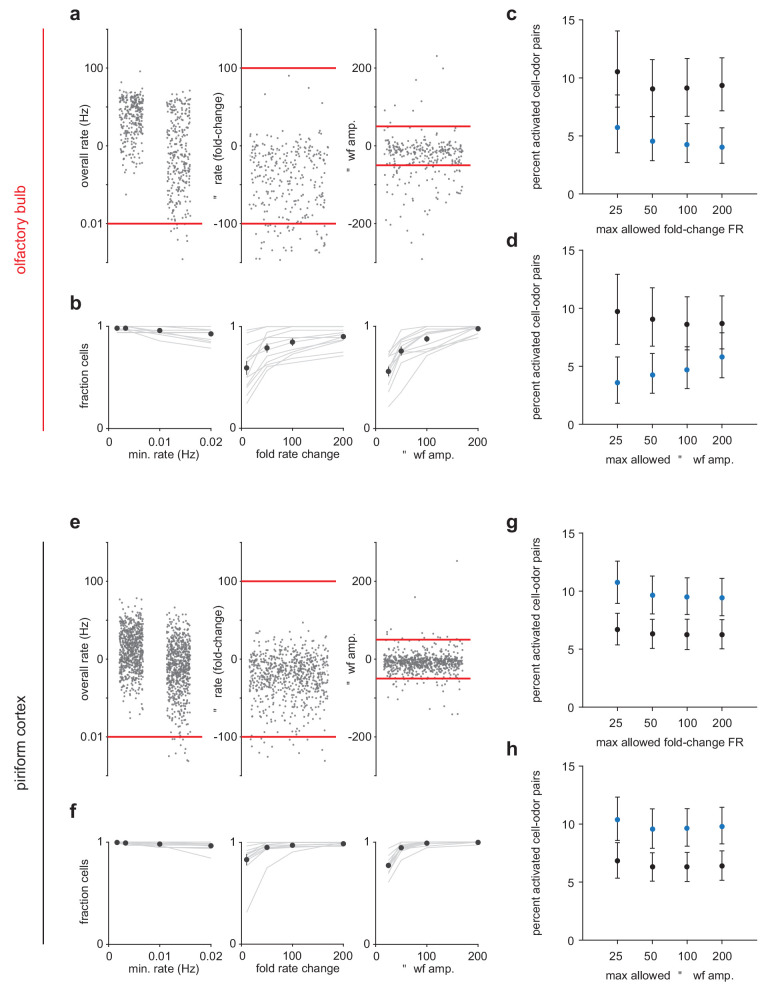
Criteria for maintaining sorted unit identity across states.(a) Left, Overall firing rates for all sorted OB units. Units falling below one spike in 0.01 Hz in either state were excluded. Middle, Fold-change in overall firing rate across states. Units with a greater than 100-fold change were excluded. Right, Change in waveform amplitude across states. Spike amplitudes for each unit were measured on the channel with the largest peak-to-peak waveforms. Units with greater than 50 μV changes in peak-to-peak amplitude were excluded. (b) Fraction of cells considered stable under varying rate (left), rate-change (middle), and waveform amplitude (right) criteria. (c–d) Primary experimental results do not depend strongly on the choice of stability criteria. The percentage of cell-odor pairs significantly activated by odor in OB is always substantially lower under anesthesia than during awake trials despite varying the rate-change (c) or waveform (d) criteria. Stricter waveform stability criteria tend to enhance the effect. (e–h) As in (a–d) but for PCx.